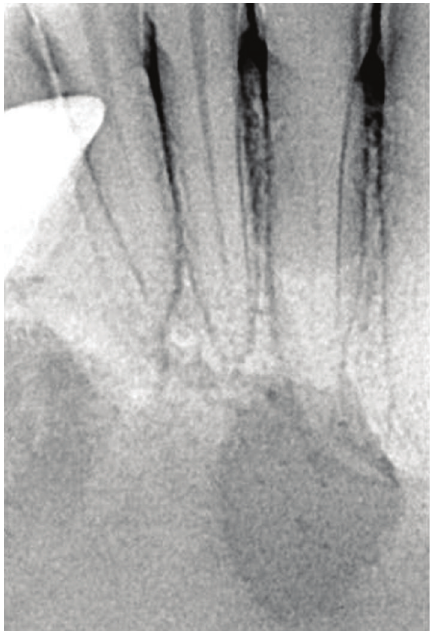
Figure 3: A large, dark radiolucency at the periapex of mandibular left central incisor.